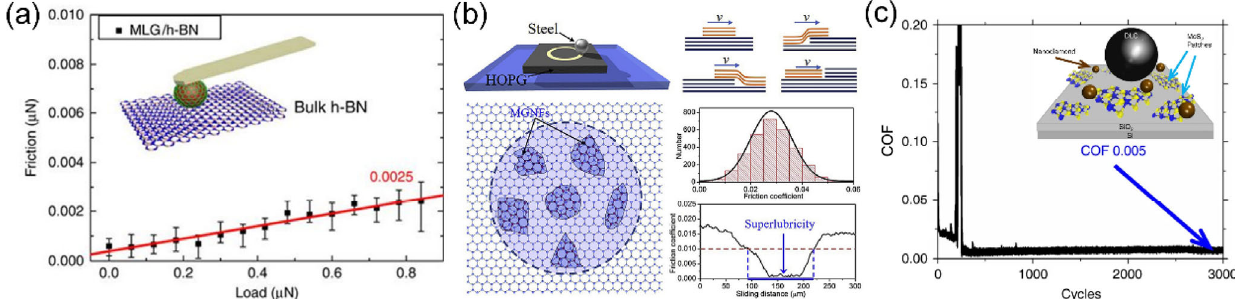
Fig. 2 (a) Microscale superlubricity obtained between a graphene-wrapped micro-ball and an h-BN surface [8]. © Springer Nature, 2017. (b) Macroscale superlubricity of a steel ball on HOPG, in which tribo-transferred MGNFs slide on the graphite surface with atomic steps and generate random occurrences of superlubricity. Reproduced with permission from Ref. [23]. © Elsevier Ltd., 2018. (c) OLC-induced macroscale solid superlubricity, the OLCs are the product of tribochemical reactions [24]. © Springer Nature,